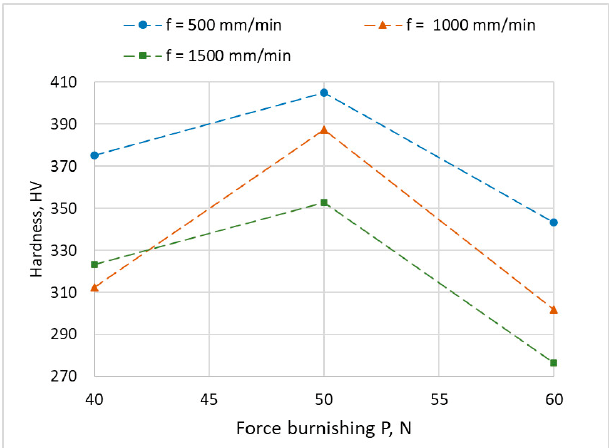
Figure 11. Influence of feed rate and force burnishing on Vickers microhardness.